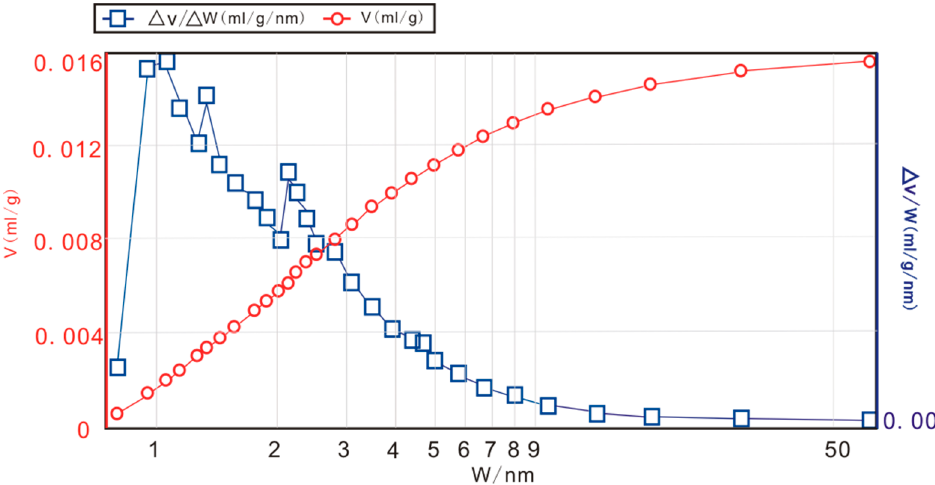
Figure 7. Statistical graph of aperture distribution (Sample #11).